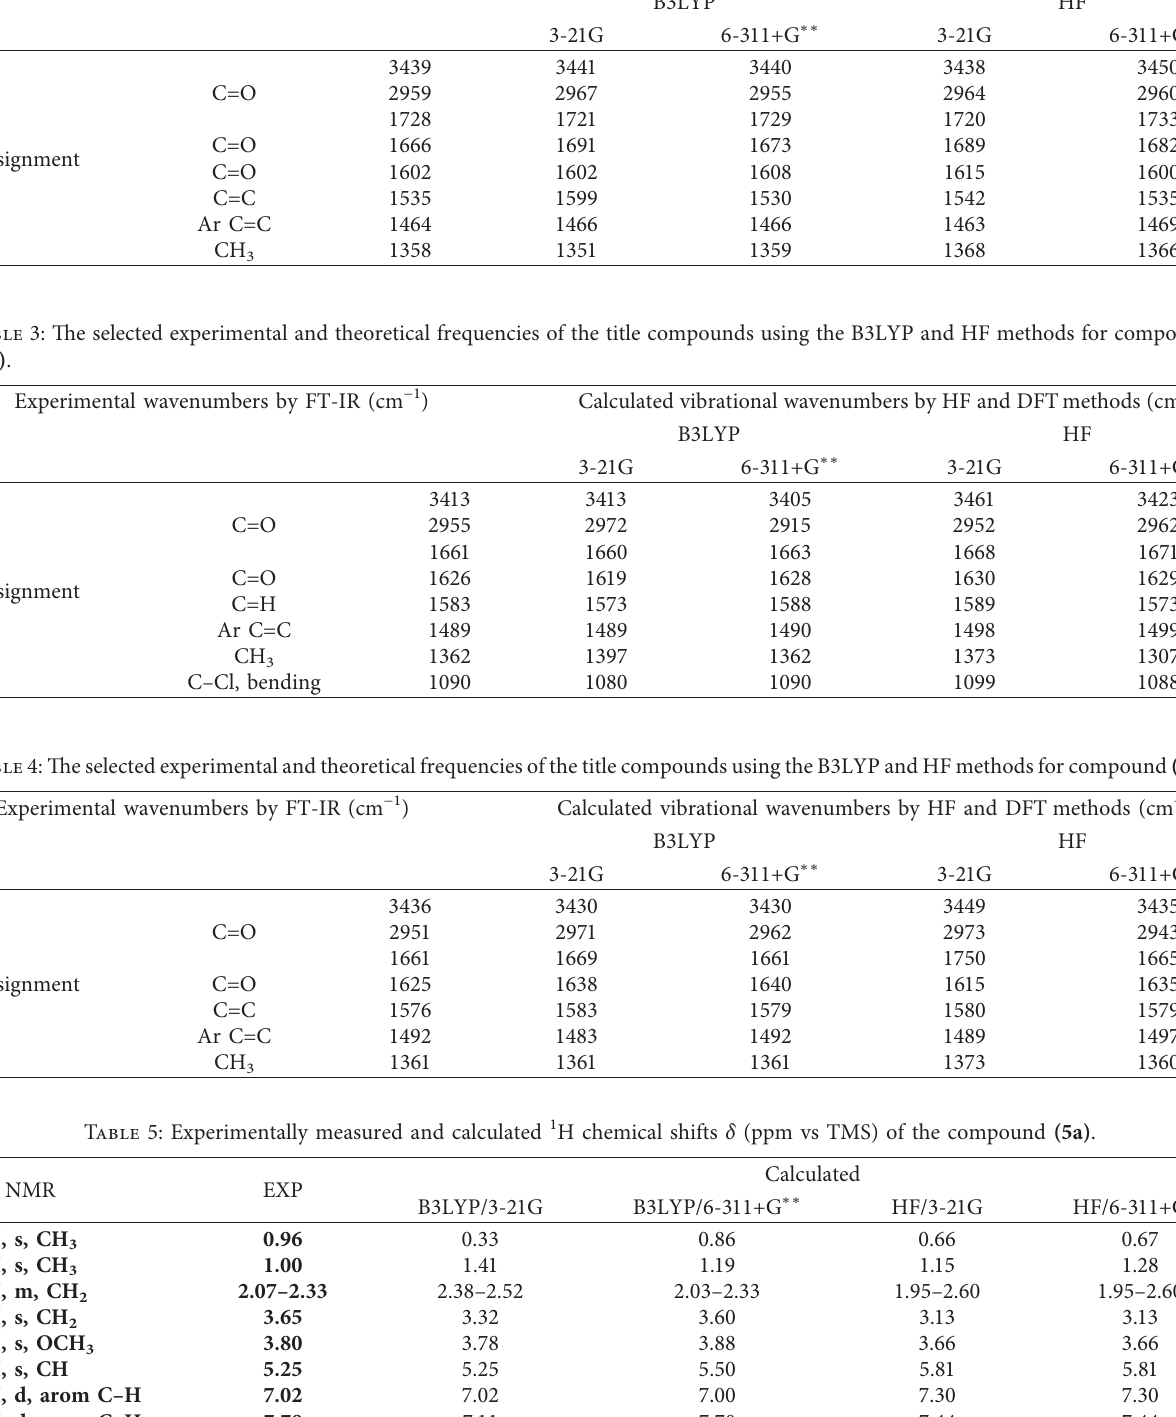
Table 2: The selected experimental and theoretical frequencies of the title compounds using the B3LYP and HF methods for compound (5a) . Experimental wavenumbers by FT-IR (cm − 1 )